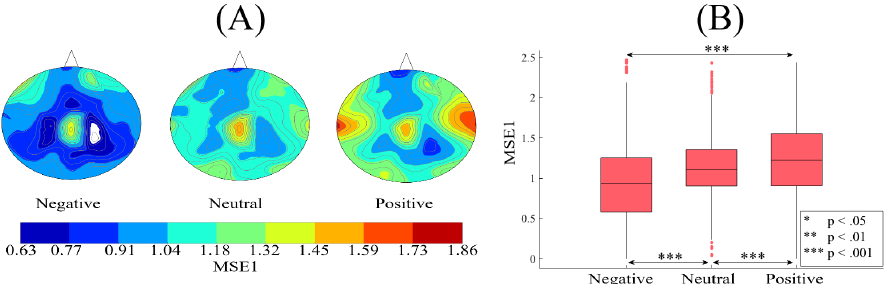
Figure 5. ( A ) Grand averages of the spatial maps of participants’ MSE1s (i.e., 62 MSE1s associated with 62 EEG channels of a participant, per affect) in negative, neutral, and positive mental states. Distribution of MSE1s in these spatial maps corresponds to the EEG channels’ arrangement in Figure 1B (i.e., one MSE1 value, per EEG channel) Differential patterns of the participants’ MSE1s that show an increase from negative to positive states is evident in these subplots. ( B ) Descriptive statistics of participants’ MSE1 in negative, neutral, and positive mental states. The asterisks mark the significant differences in these